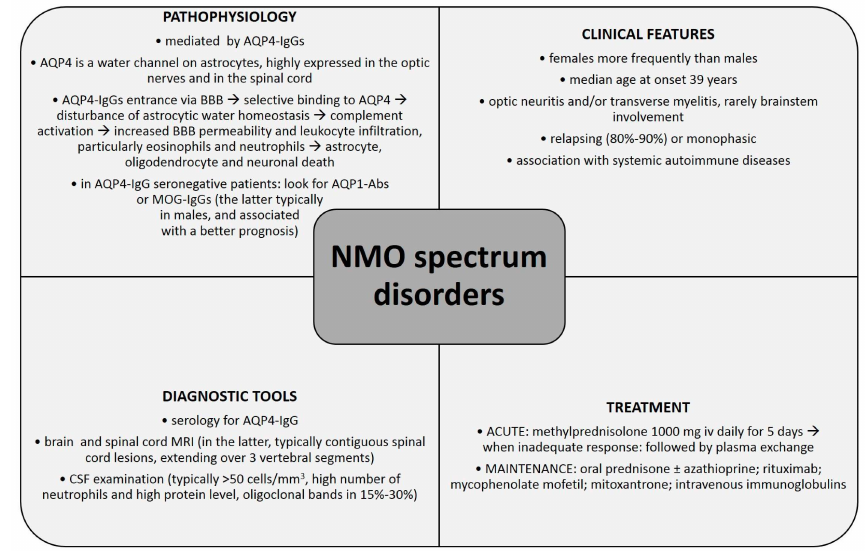
Figure 5. Basic summary of the current knowledge on NMO spectrum disorders.